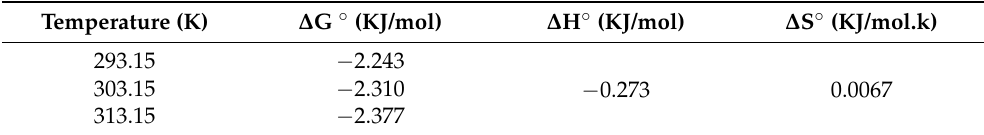
Figure 7. Thermodynamic calculations; ( a ) effect of temperature on MB adsorption, ( b ) Arrhenius plot showing ln (K d ) Vs. 1/T using isotherm data generated at C 0 = 500 ppm (maximum MB removal). Table 7. Thermodynamic parameters for the adsorption of MB by